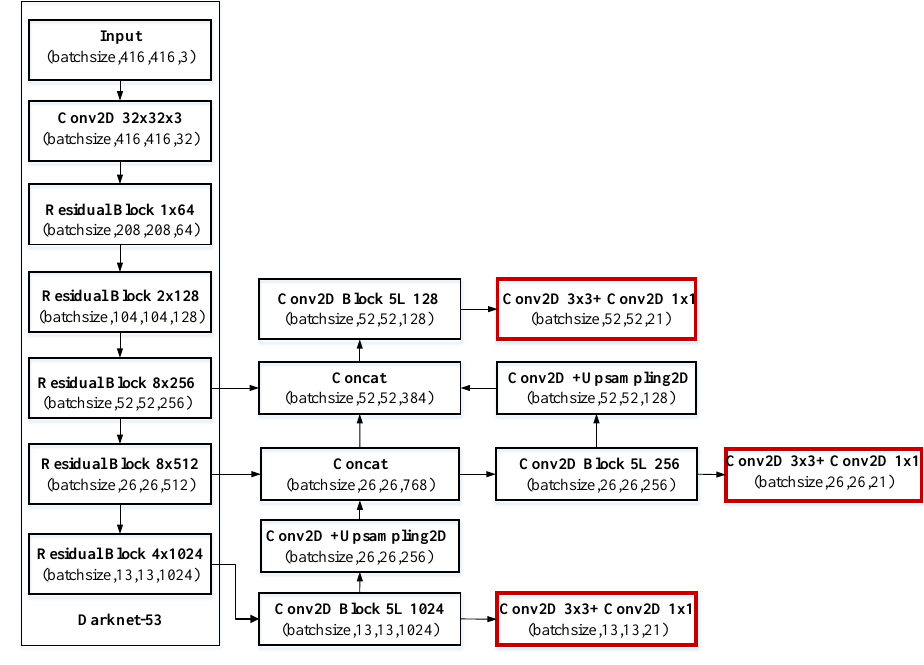
Figure 1. Original YOLOv3 network